Question: Looking at the figure, what chart type is it?
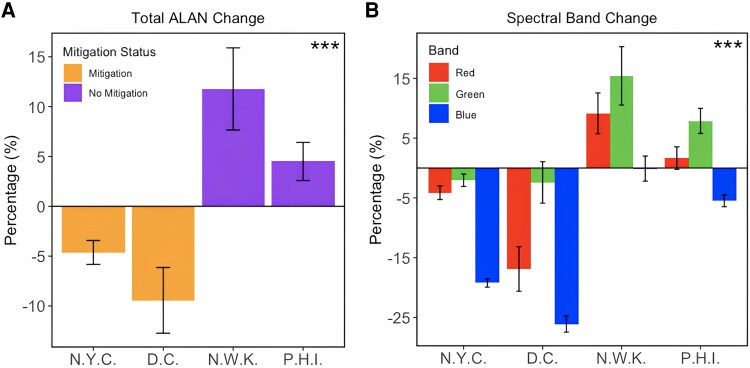
Answer: bar